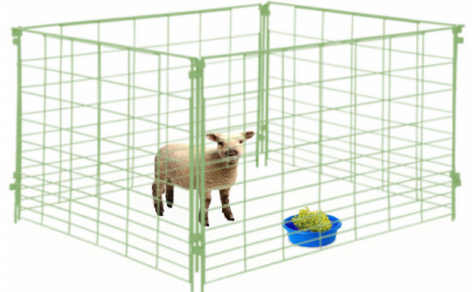
Figure 2. On-station trial for the evaluation of in vivo anthelmintic properties of plants. When one plant species is under evaluation, the voluntary feed intake might be related with the dynamics of GIN infection. Nutritional and immunological aspects should be also considered. Some researchers choose to hang experimental plants to simulate browsing ingestive behaviors. Such considerations should be the function of the facilities where trials are conducted.